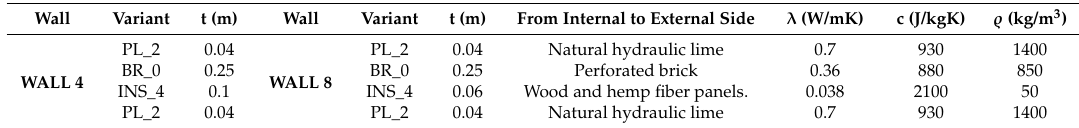
Table 2. Stratigraphy of walls variants.